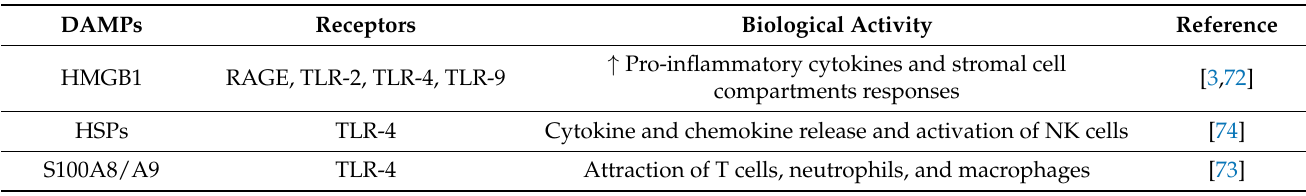
Table 1. DAMPs and their implications in